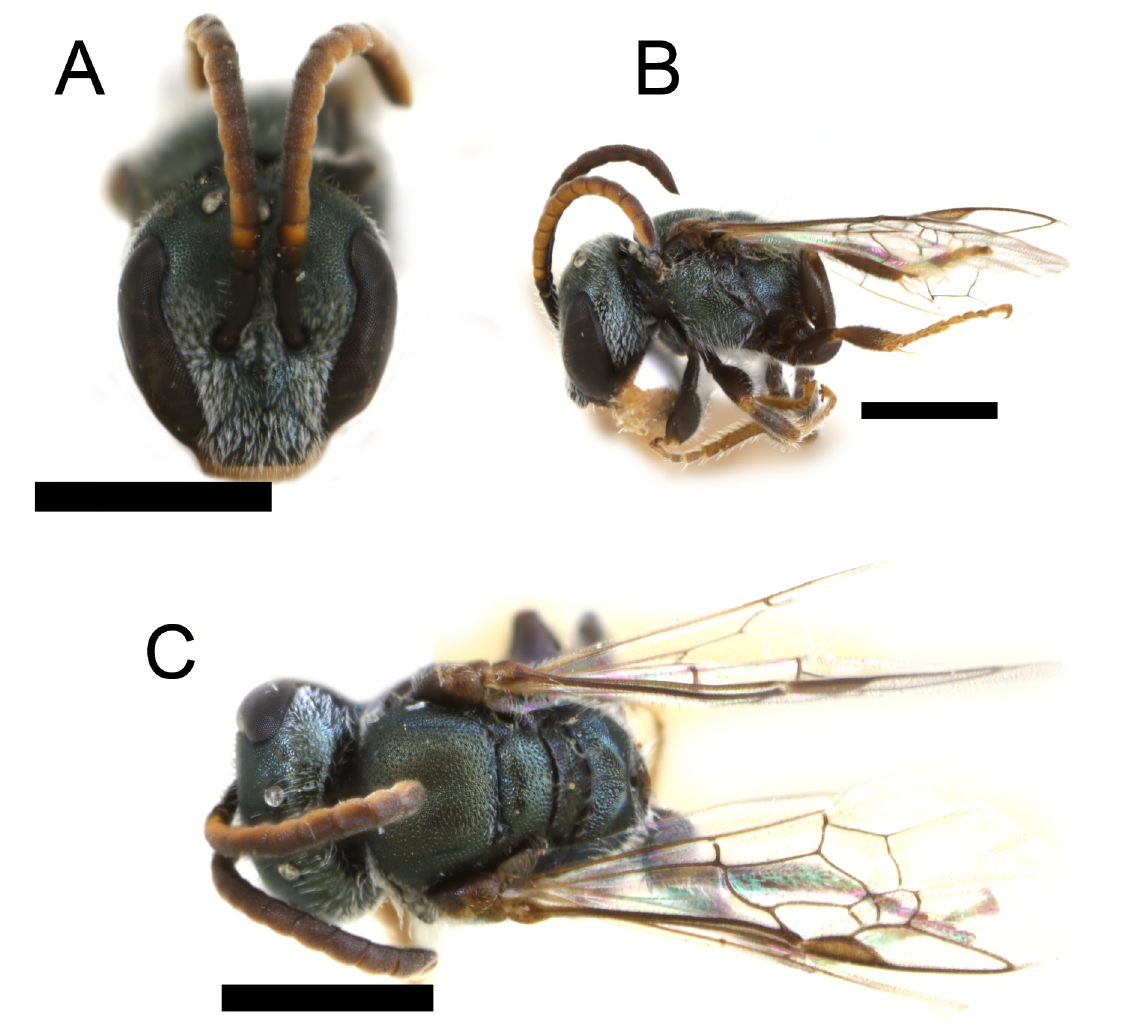
Fig. 13. Lasioglossum monense sp. nov., ♂. A . Face. B . Lateral habitus. C . Dorsal habitus. Scale bars = 1